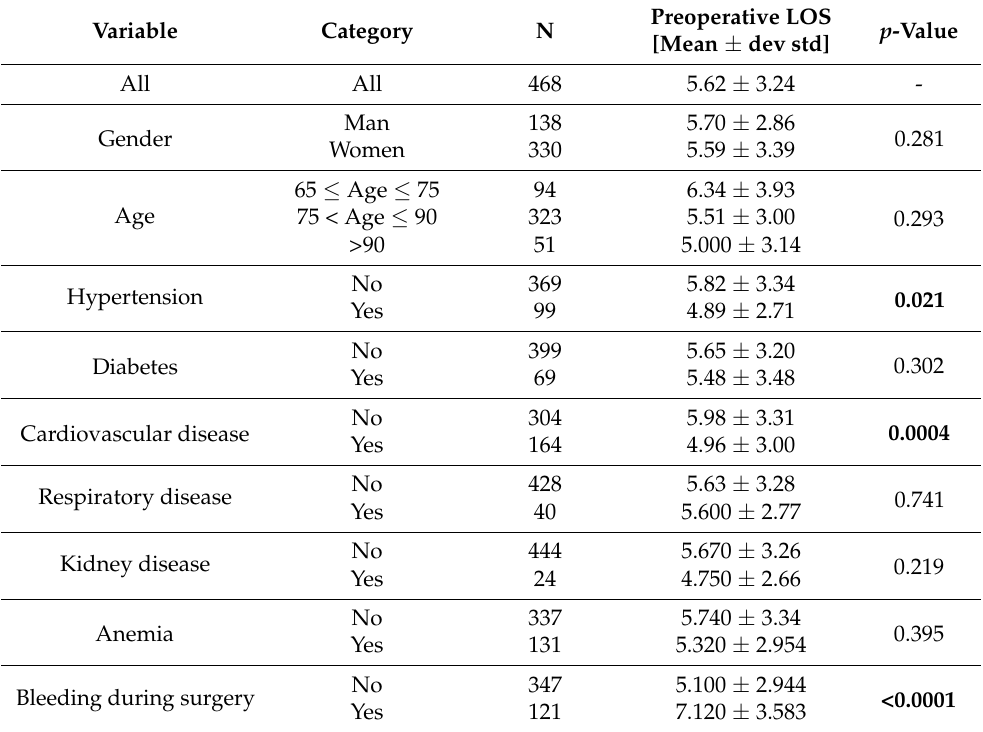
Table 2. Variables influencing preoperative LOS